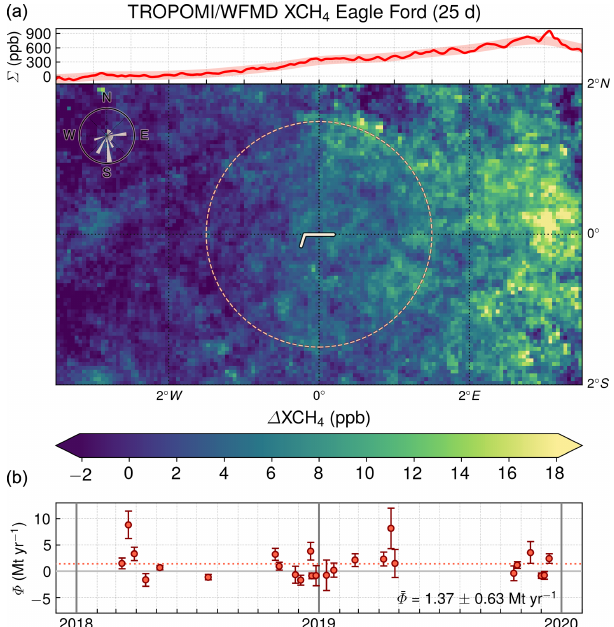
Figure 8. As Figs. 4, 5, and 7 but for the Eagle Ford formation. The coordinates of the pivotal point are 28 . 5 ◦ N, 99 ◦ W. To avoid the background being impacted by offshore sources, wind directions blowing towards the northwest were additionally excluded.